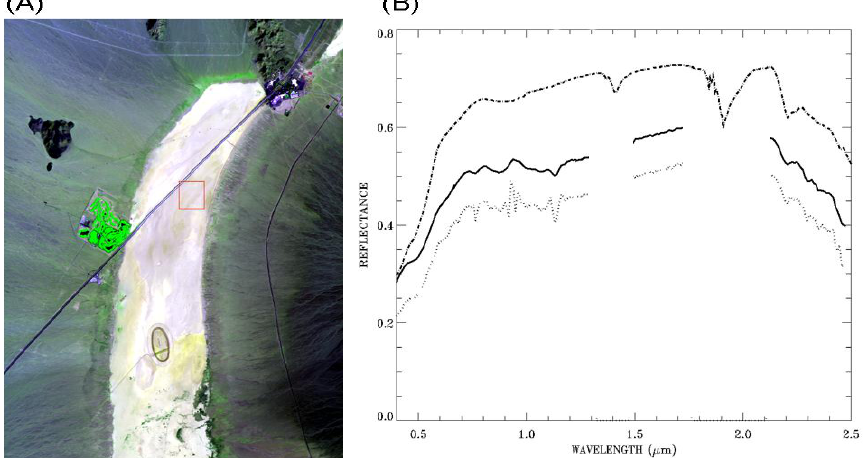
Figure 8. ( A ): a false color image (Red: 0.63 μ m; Green: 0.86 μ m; Blue: 0.47 μ m) for an AVIRIS scene over Ivanpah in California, and ( B ): an ATREM-derived surface reflectance spectrum over an Ivanpah playa pixel (dotted line), the corresponding smoothed spectrum (solid line), and a field-measured spectrum (dash-dotted line). See text for more detailed